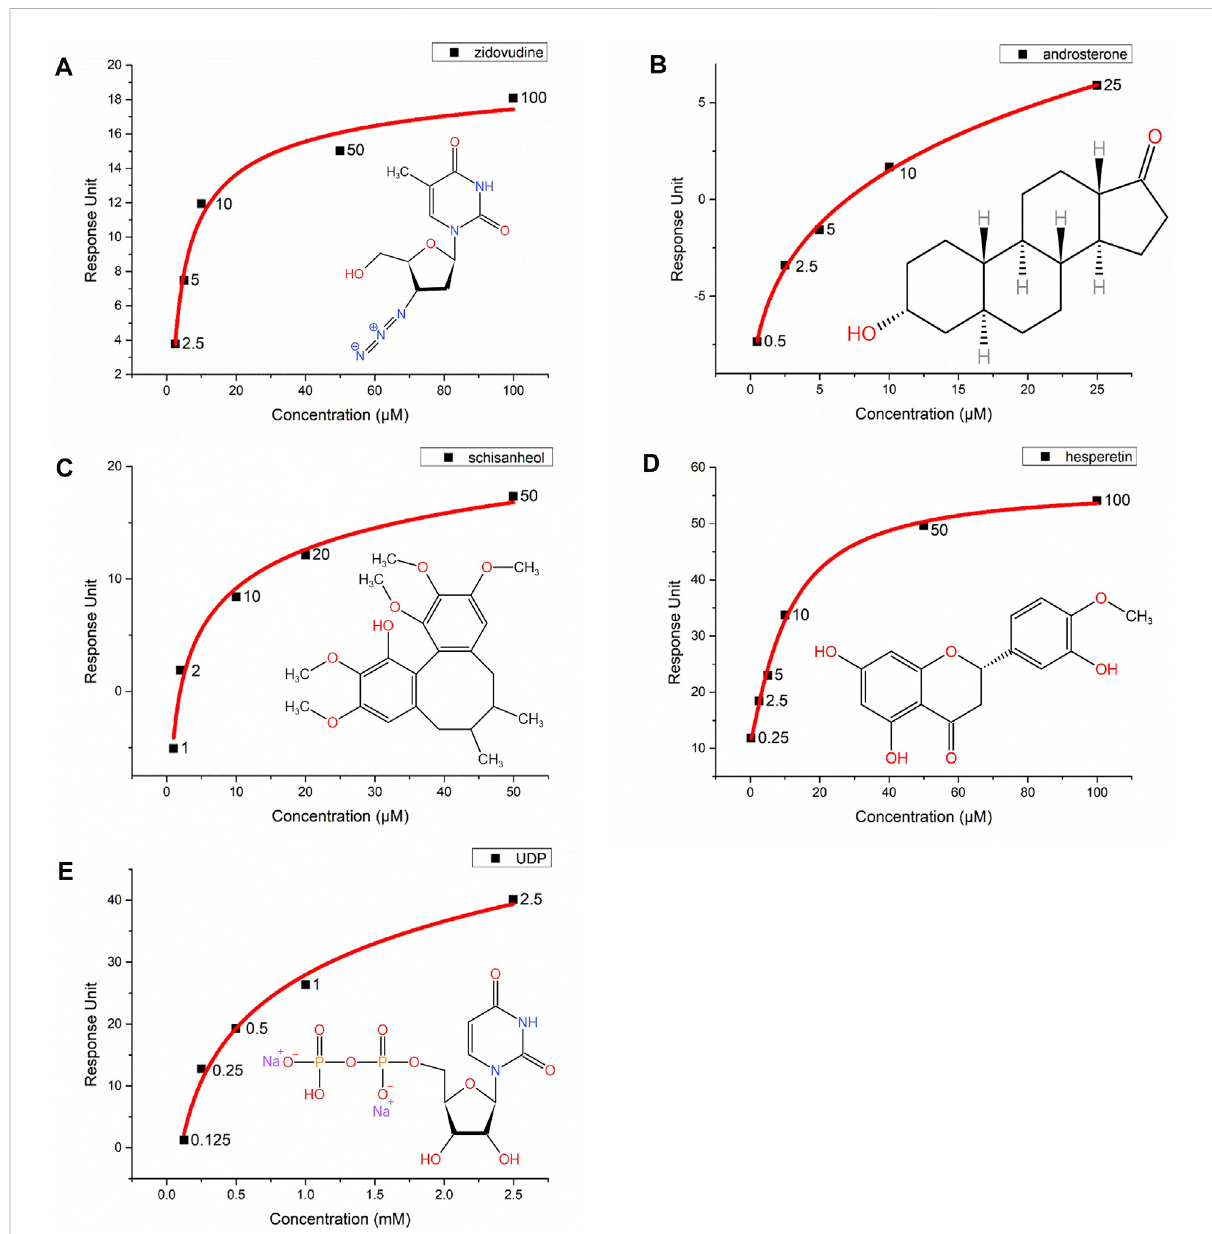
FIGURE 7 Interactions of fi ve compounds with the UGT2B7(N315A)-BRIL proteins by surface plasmon resonance (SPR). Concentration-response curves of (A) zidovudine, (B) androsterone, (C) schisanhenol, (D) hesperetin, and (E) UDP. The X -axis represents the concentrations of substrates and Y -axis shows the response units from SPR. The chemical structures are marked at the right corner of each